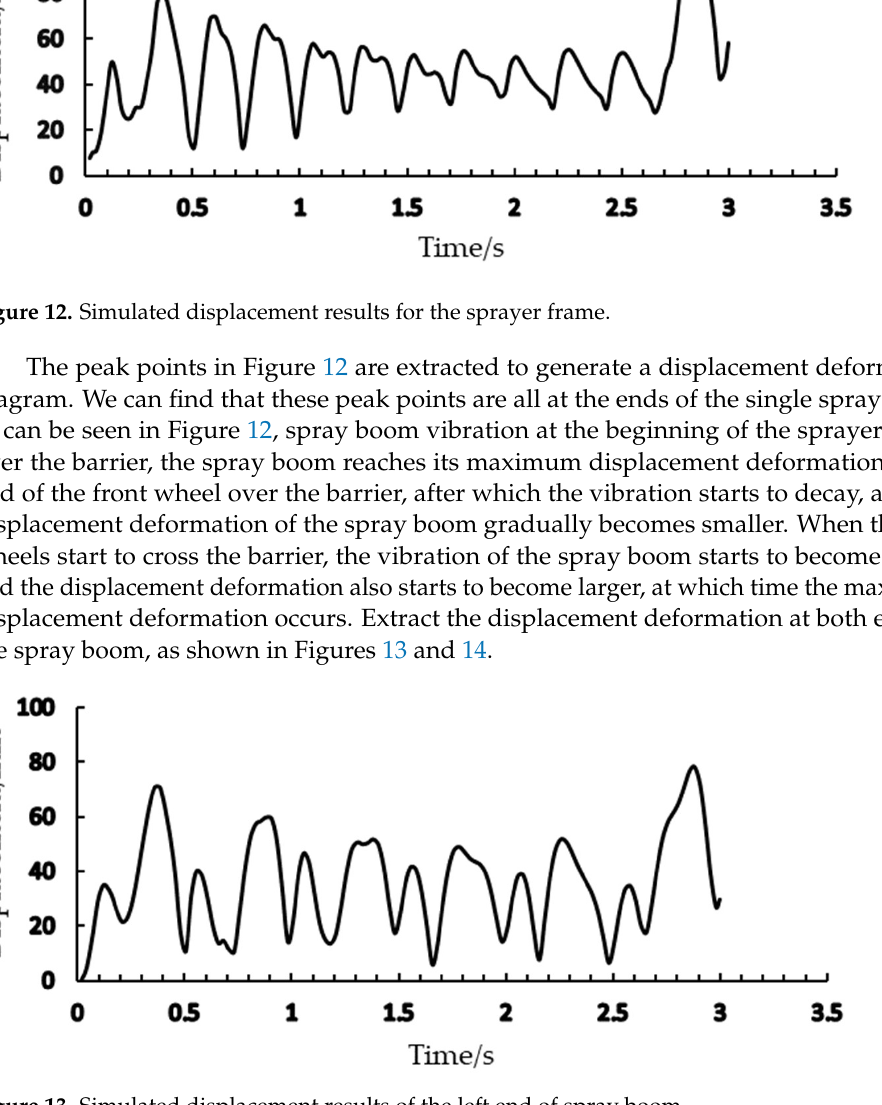
Figure 13. Simulated displacement results of the left end of spray boom.